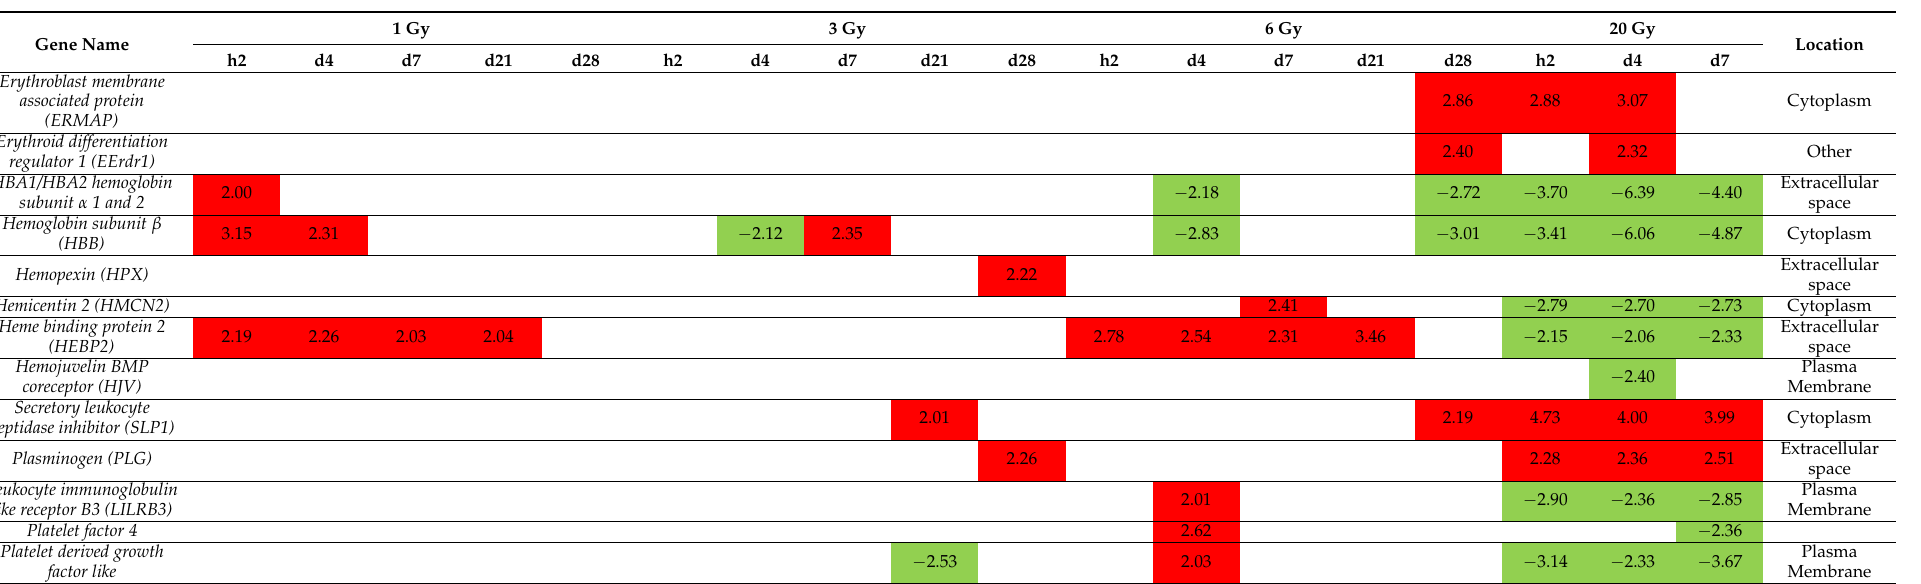
Table 2. Significantly differentially transcribed genes (SDTGs, p ≤ 0.05 and FC ≥ 2) with an impact on hematological functions. Red-filled cells indicate upregulation and green-filled cells indicate